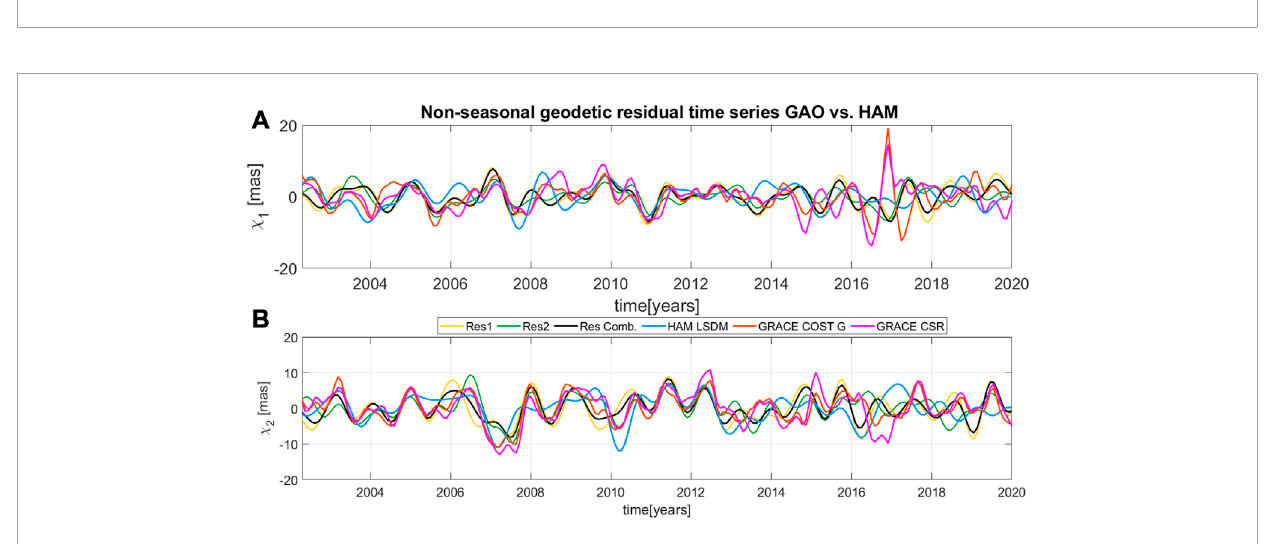
FIGURE 9 Comparison of non-seasonal oscillations of the equatorial components of the χ 1 (A) and χ 2 (B) geodetic residuals (Res1, Res2, Res Comb.) and for different hydrological-based excitations of polar motion (LSDM, COST-G, and CSR solutions).